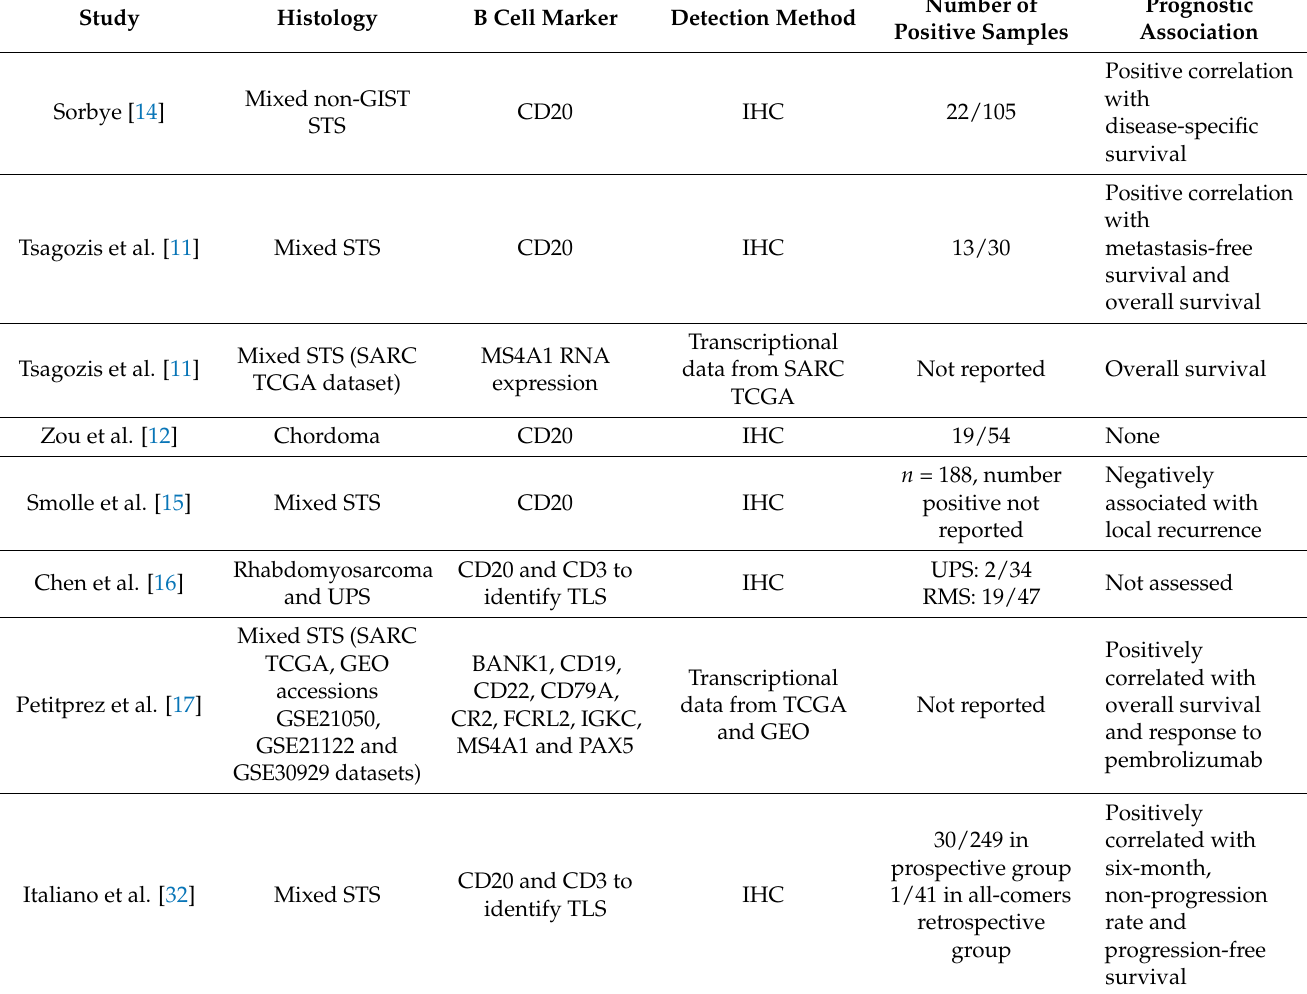
Table 1. Summary table of B cell presence in sarcoma clinical tissue. Table includes both retro- spective statistical analyses using established cancer genomic databases as well prospective data. Abbreviations: GEO, gene expression omnibus; GIST, gastrointestinal stromal tumor; IHC, immuno- histochemistry; RMS, rhabdomyosarcoma; SARC TCGA, the Cancer Genome Atlas, sarcoma; STS, soft tissue sarcoma; UPS, undifferentiated pleomorphic